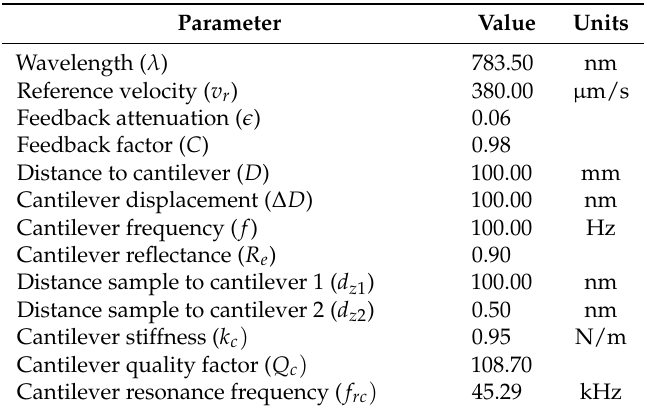
Table 1. Parameters for cantilever displacement